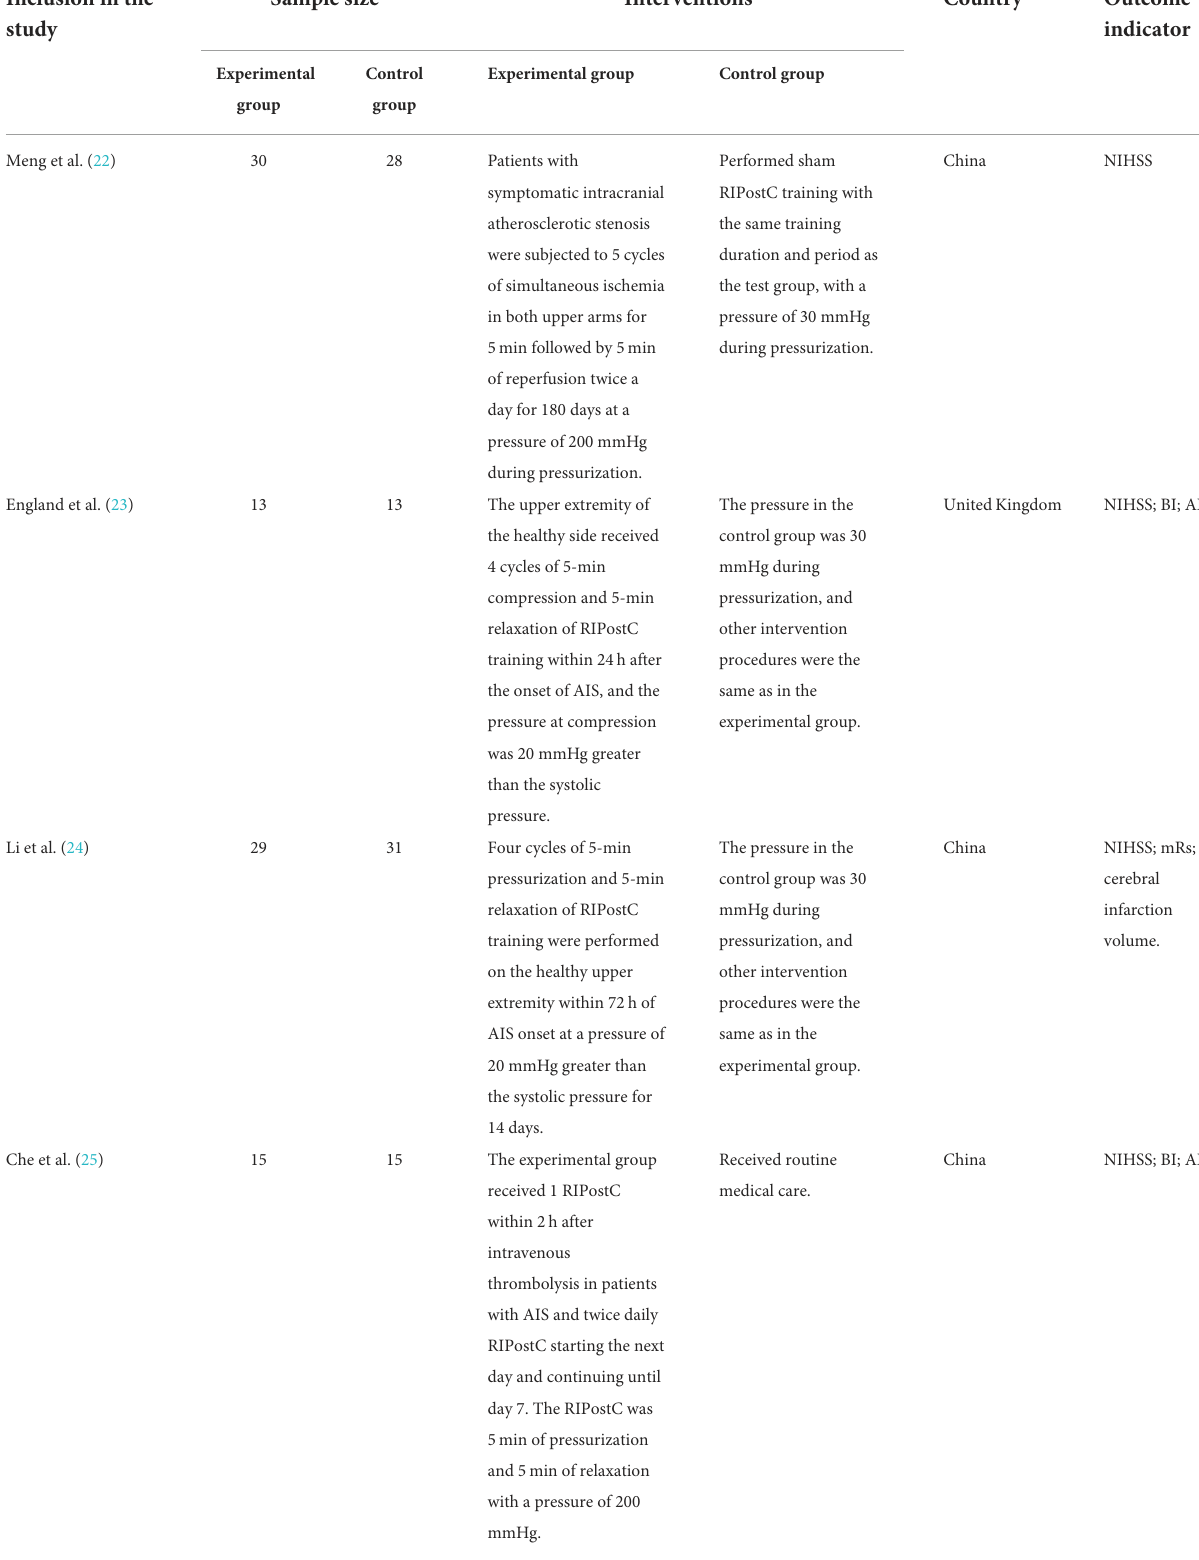
TABLE 2 Research